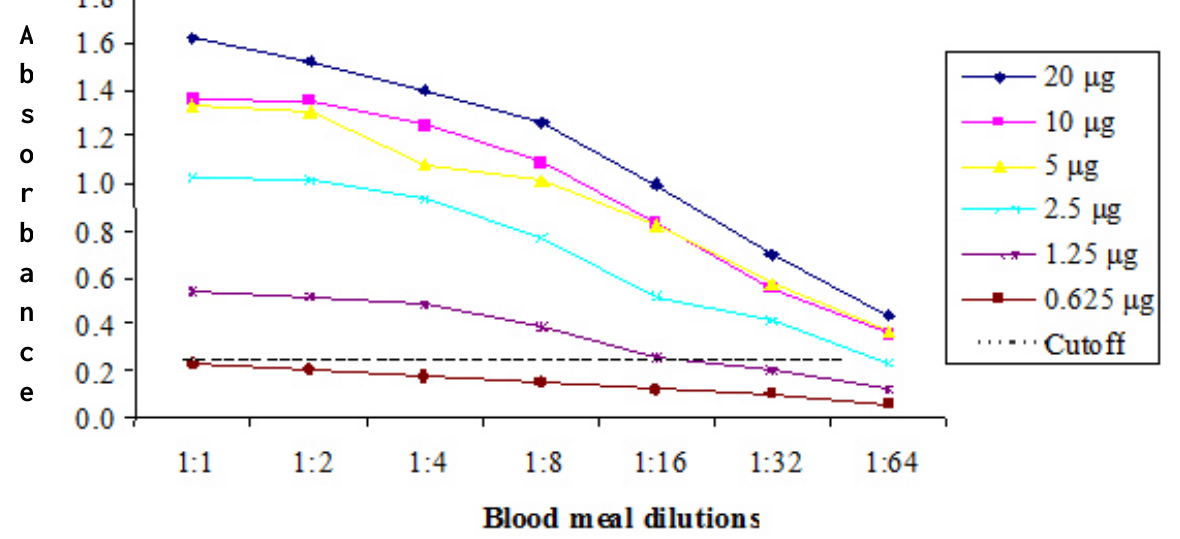
Figure 1. ELISA optimization with monoclonal anti-human IgG1.